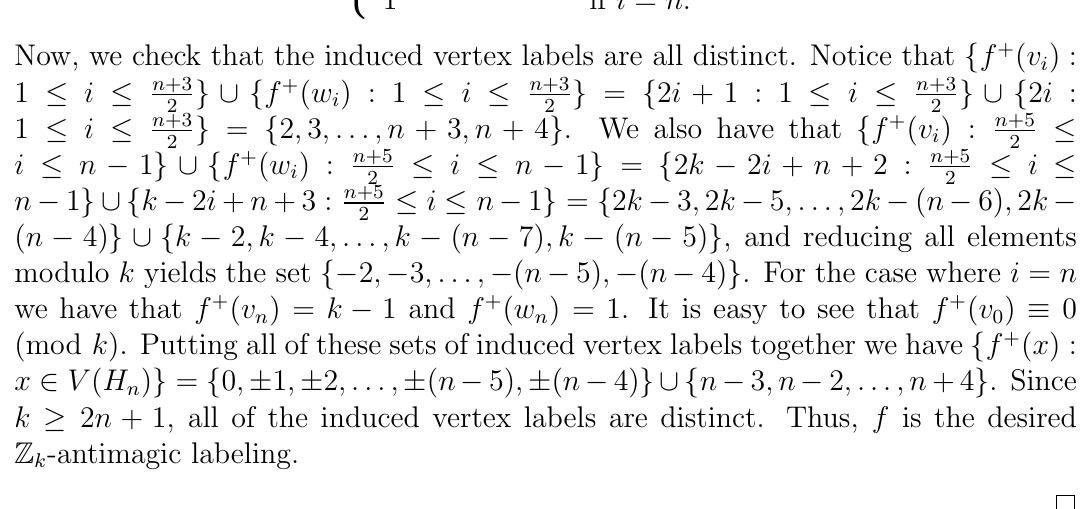
for k (cid:21) 5, and a Z 2